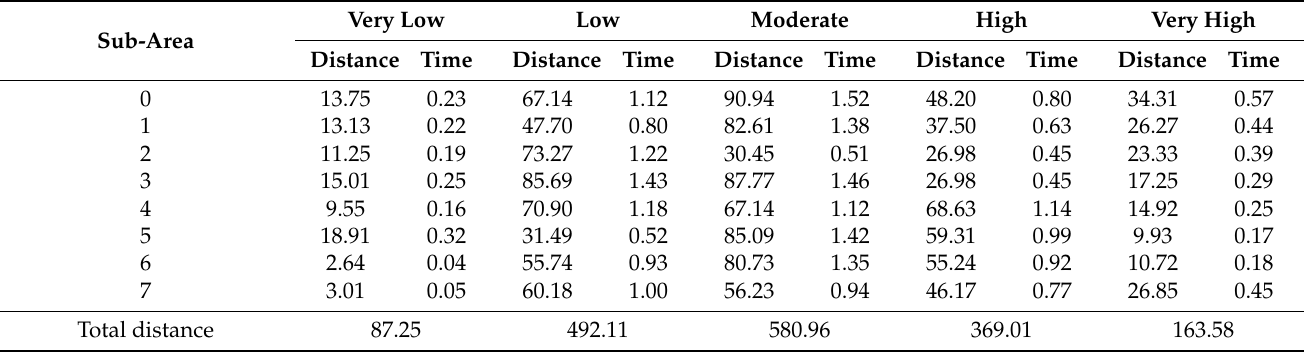
Table 3. Flight distance and time corresponding to each area obtained by multiple